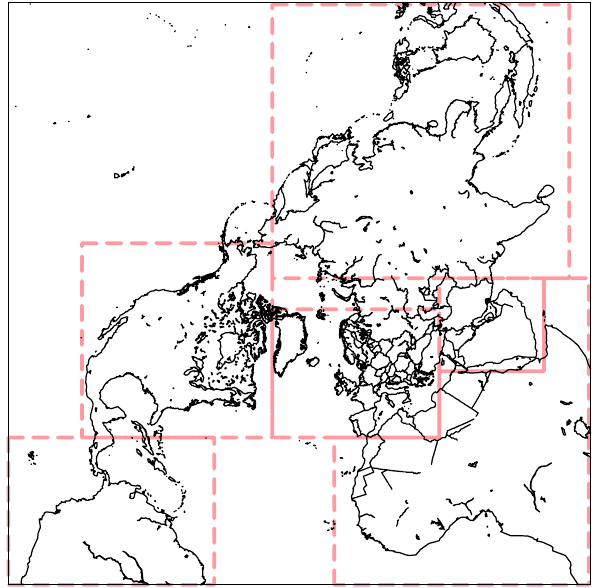
Fig. 15. The DEHM mother domain used in this study which cov- ering more than the Northern Hemisphere, together with six re- gions; North America, South America, Asia, Europe, Middle East and Africa. Total contributions from individual natural source cate- gory to ozone and PM 2 . 5 level over the six regions are